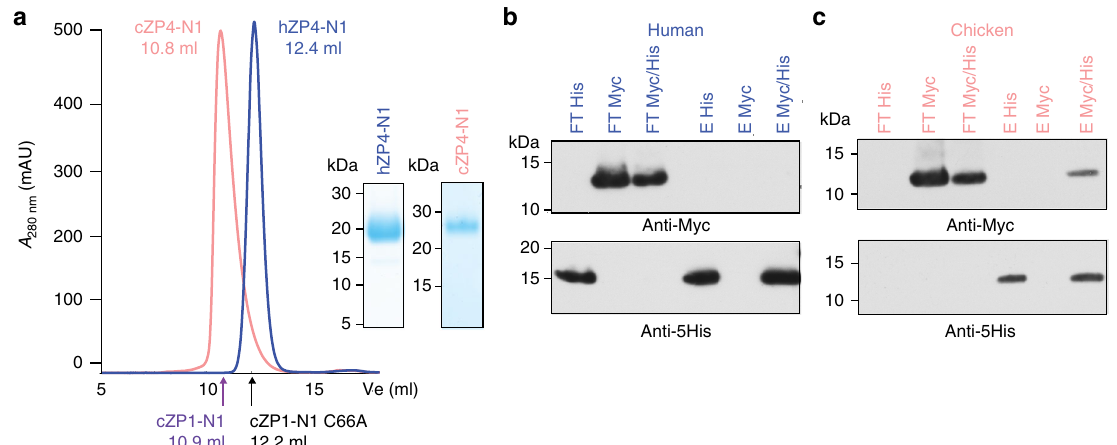
Fig. 9 ZP4-N1 forms a non-covalent homodimer in chicken, but not in human. a SEC analysis of puri fi ed hZP4-N1 and cZP4-N1 and non-reducing Coomassie-stained SDS-PAGE analysis of the corresponding peak fractions. Peaks are normalised to 500 mAU, and elution volumes of the cZP1-N1 homodimer and the cZP1-N1 C66A monomer are indicated. b , c Immunoblot analysis in reducing conditions of His-pull-down experiments of